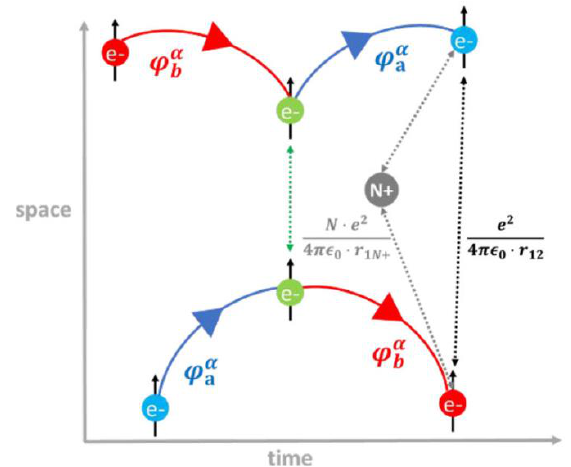
Figure 3. Feynman-type diagram (space (X) vs. time (Y)) of a quantum spin exchange interaction (QSEI) between two electrons with the same spin ( α ) in 𝜑 𝑎𝛼 and 𝜑 𝑏𝛼 orbitals. The curved lines define the space – time evolution of the electrons in 𝜑 𝑎𝛼 and 𝜑 𝑏𝛼 , under the influence of the repulsive quantized Coulomb potentials formed between the electrons. The direction of the space (y) – time (x) development is indicated by the arrow [19,54]. Adapted with permission from Biz, C.; Fianchini, M.; Gracia, J. Strongly Correlated Electrons in Catalysis: Focus on Quantum Exchange. ACS Catalysis